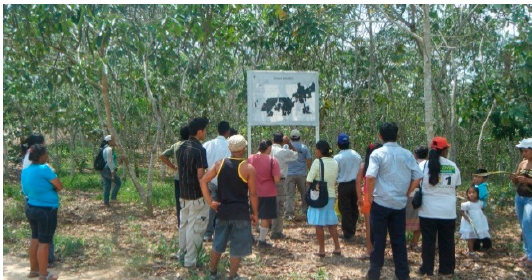
Figure 18. Visitors in one of the guided tours to the Campo Verde Project.